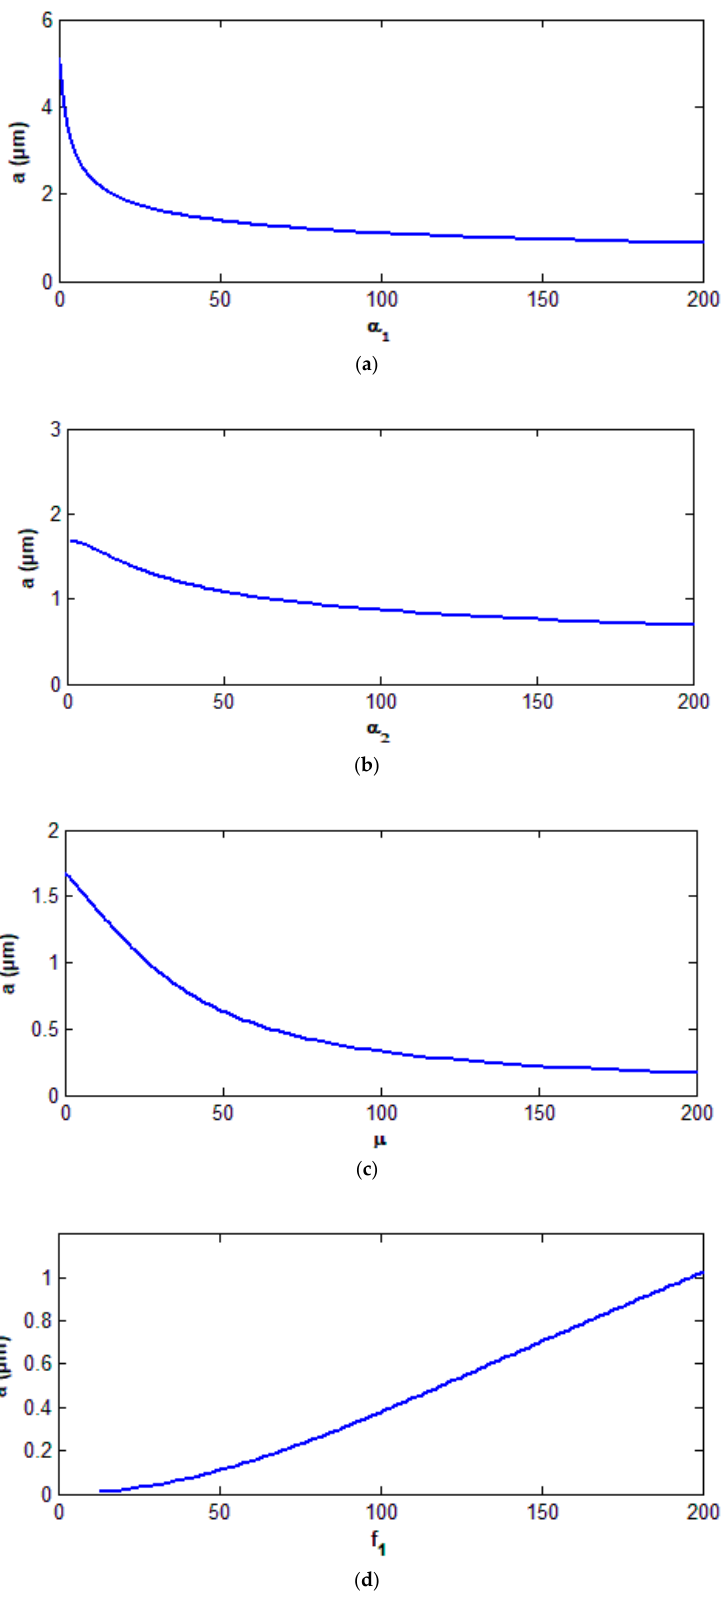
Figure 5. ( a ) E ff ect of the gain α 1 for the controlled system response at σ 1 = 0. ( b ) E ff ects of the gain α 2 for the controlled system response at σ 1 = 0. ( c ) E ff ects of linear damping µ for the controlled system response at σ 1 = 0. ( d ) E ff ects of parametric force f 1 for the controlled system response at σ 1 =